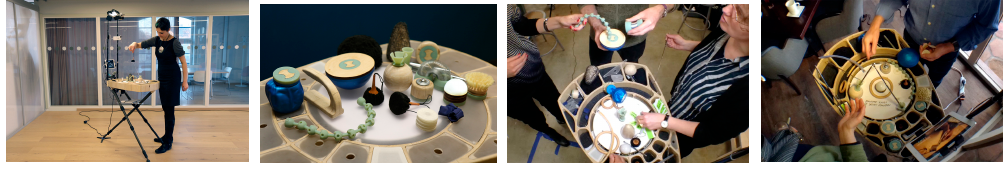
Figure 6 Embodied Encounters Studio. Figure 6. Embodied Encounters